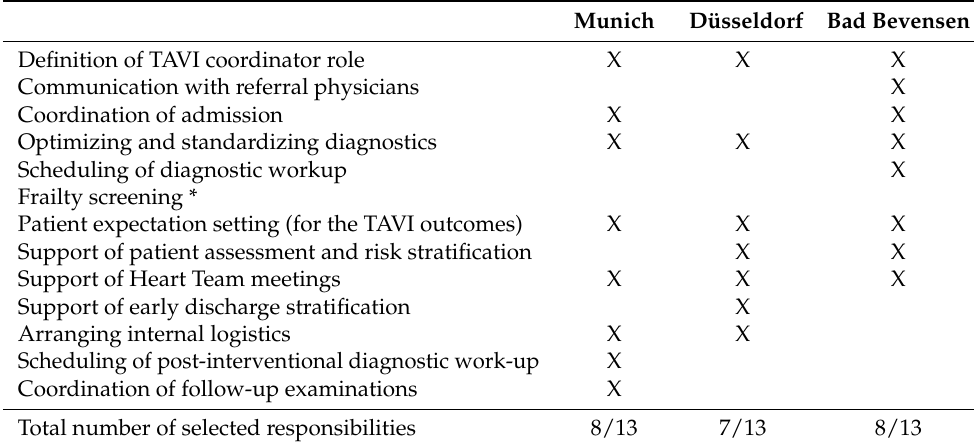
Table 1. Center-specific additions to the TAVI coordinator responsibility beyond those already implemented prior to